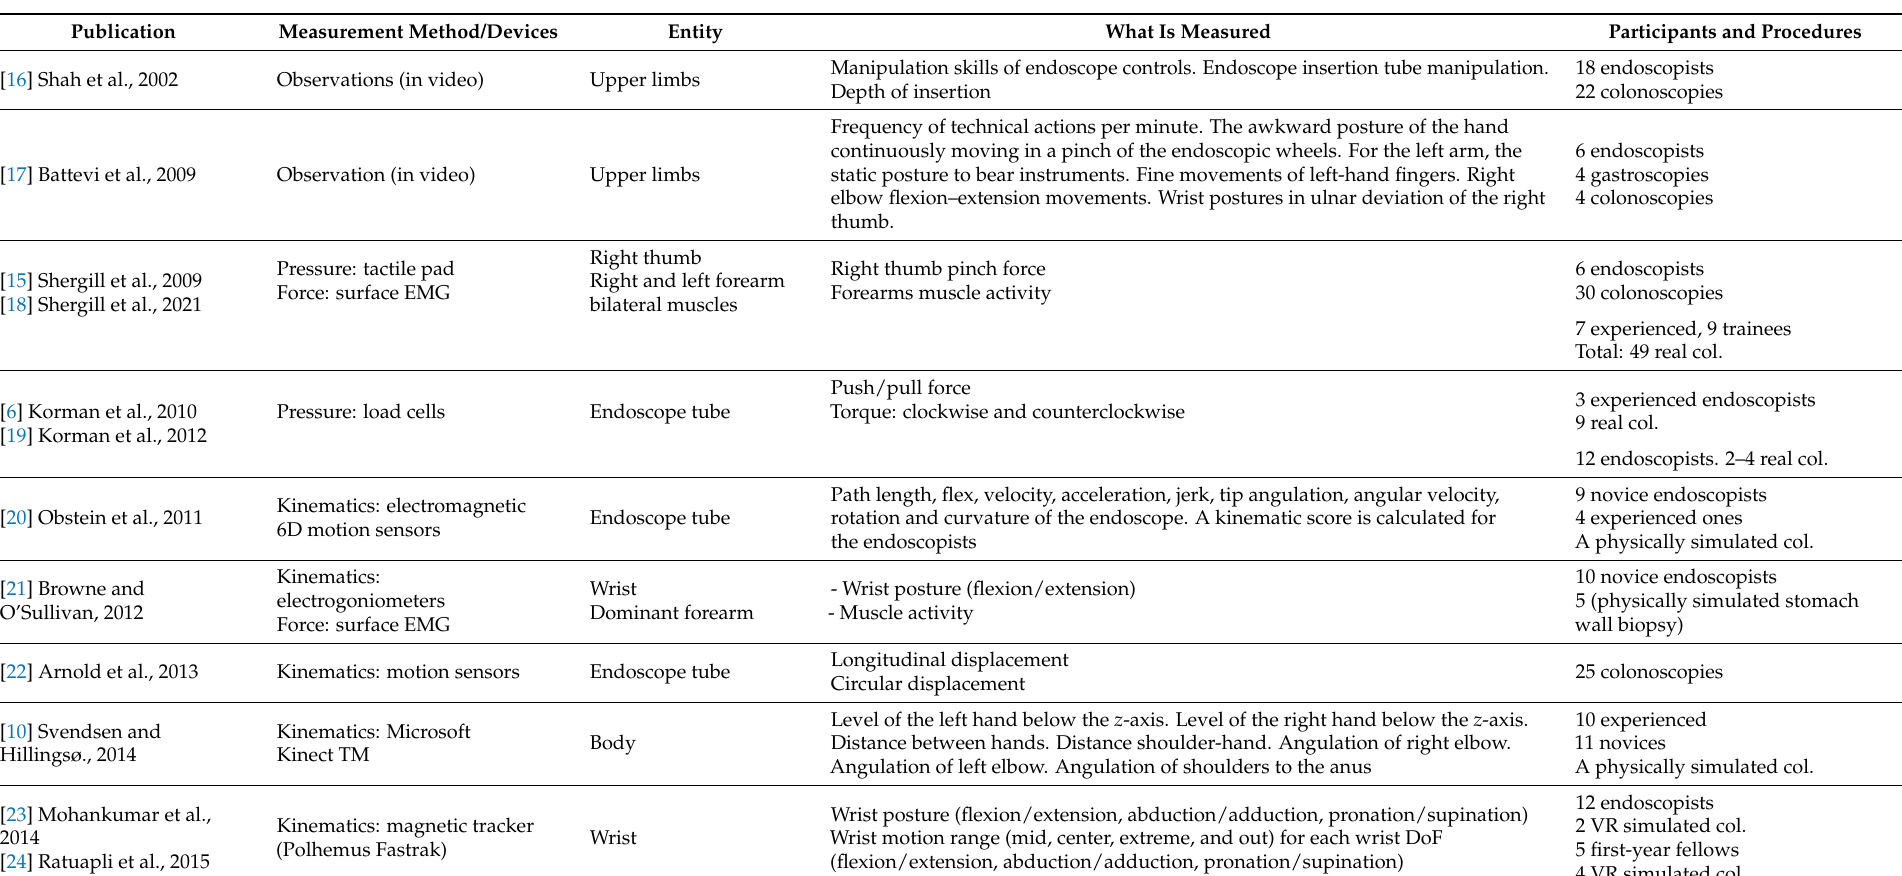
Table 1. Publications about quantification related to the performance of gastrointestinal endoscopy procedures (“col.” stands for